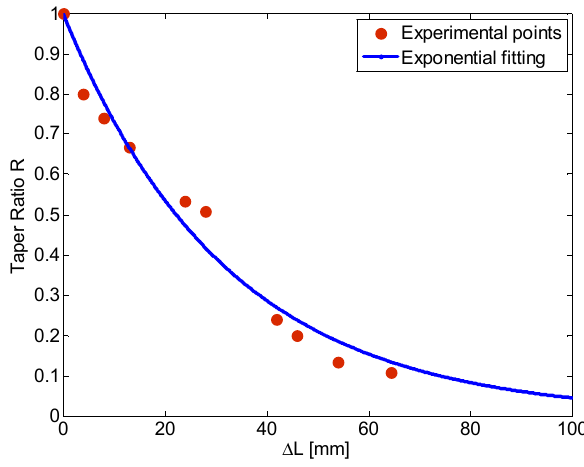
Figure 4. Taper ratio R versus the total elongation Δ L